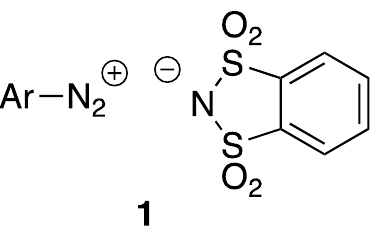
Figure 1. Arenediazonium o -benzenedisulfonimides 1 .